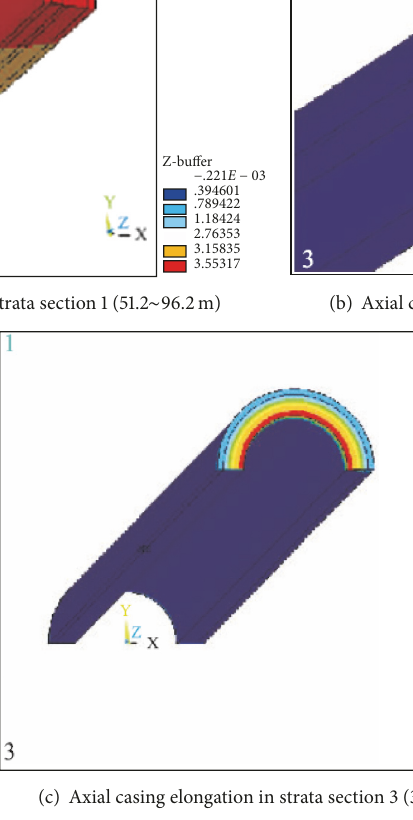
Figure 6: Axial casing elongation in different strata